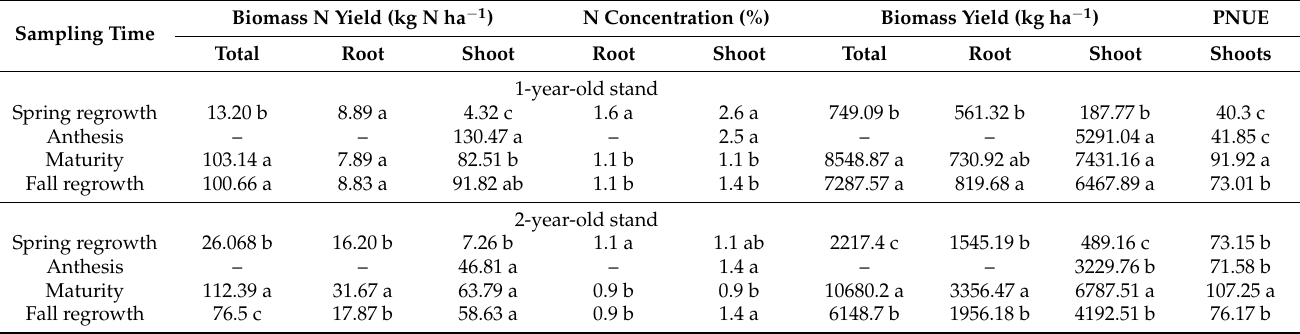
Table 3. Seasonal N yield, nitrogen concentration, and